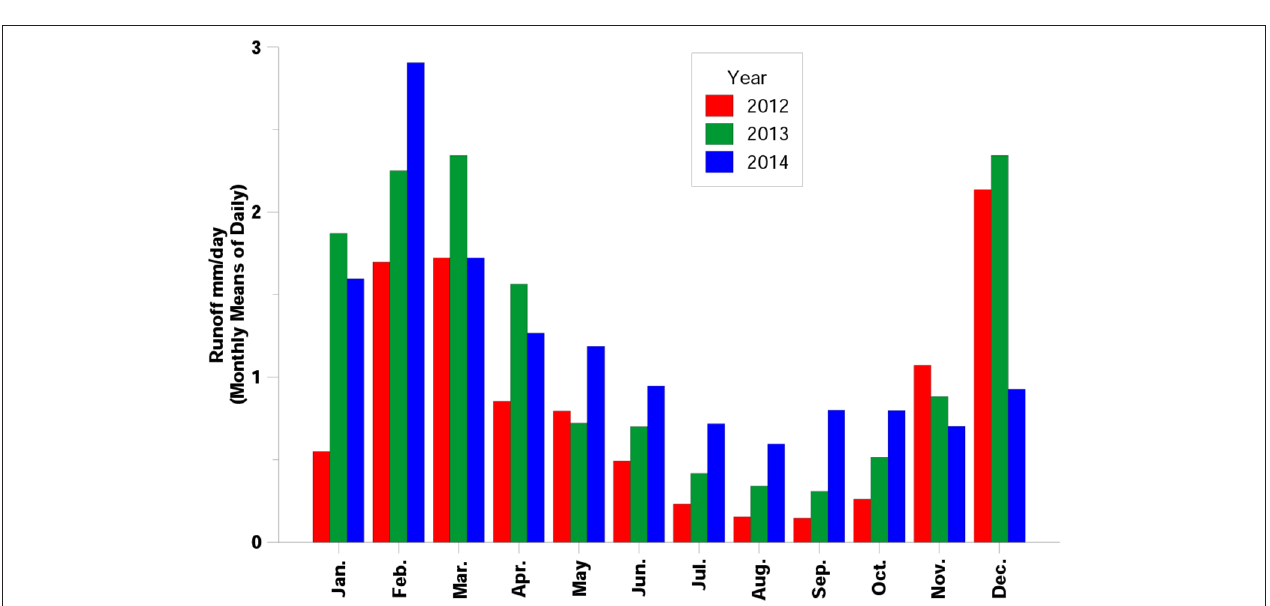
FIGURE 6 | Monthly mean climatology of the surface river runoff for the period 2012–2014. Precipitation is the variable that imposes mm / day to the ERA Interim surface runoff data.